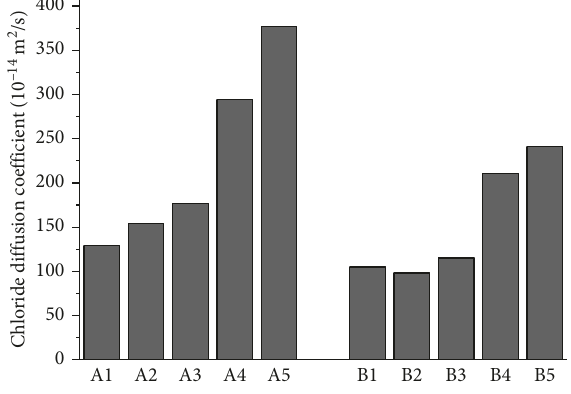
Figure 3: Chloride diffusion coefficient of concrete.